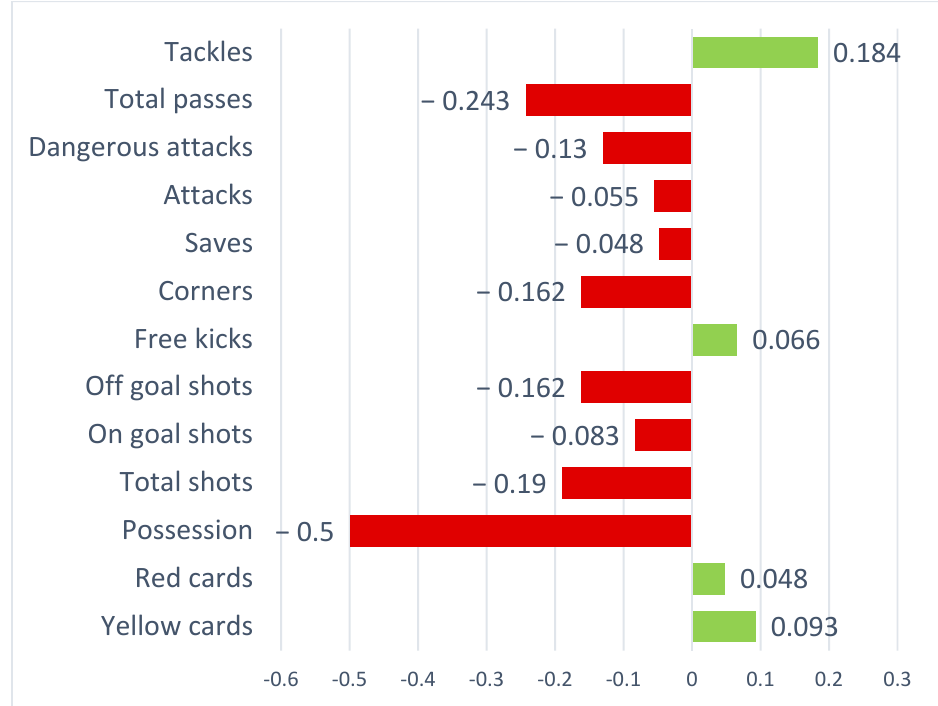
Figure 2. Autocorrelations of the PIs.